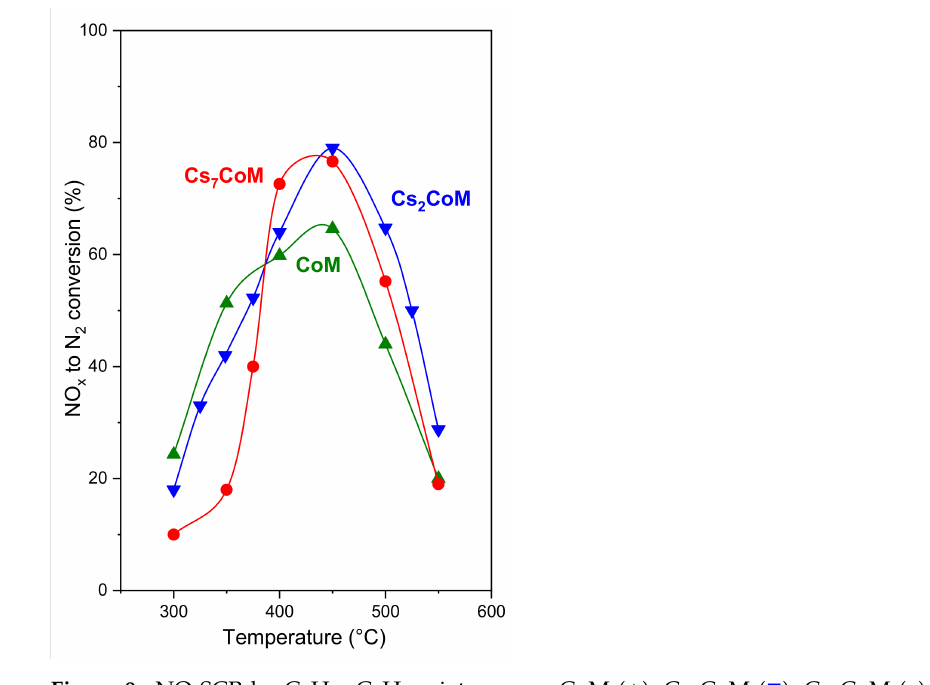
Figure 9. NO-SCR by C 4 H 10 -C 7 H 8 mixture over CoM ( (cid:78) ), Cs 2 CoM ( (cid:72) ), Cs 7 CoM ( • ). Reaction conditions: 1000 ppm NO, 250 ppm toluene, 500 ppm butane and 2 vol.% O 2 , He balance and total flow 133